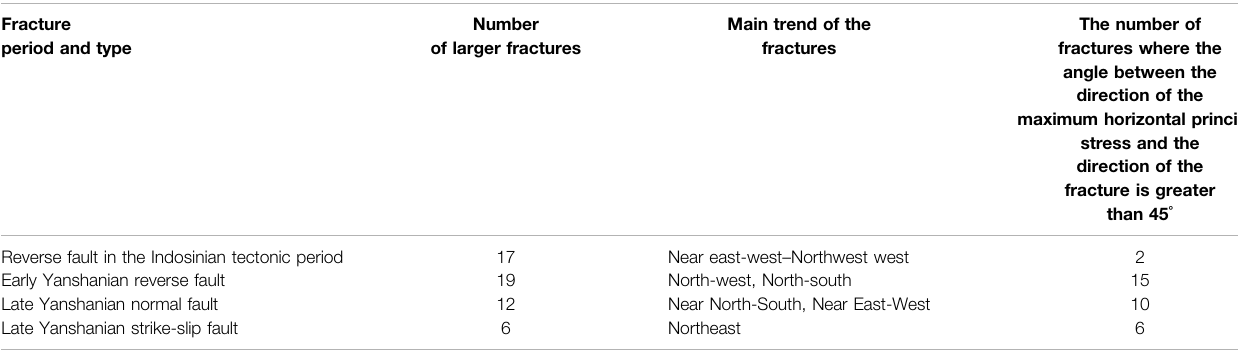
TABLE 1 | The Angle between the fault strike and the direction of the maximum horizontal principal stress in Jingmen block. Fracture period and type